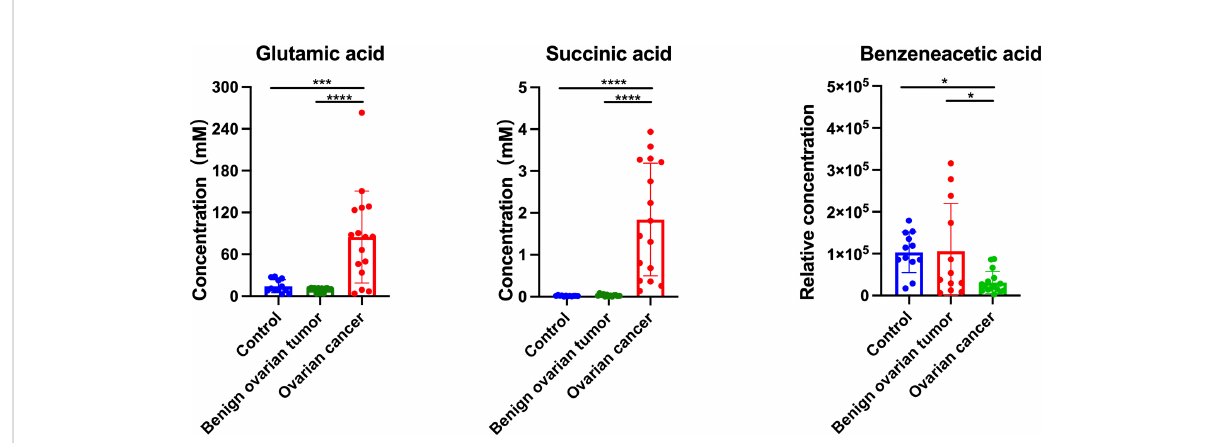
FIGURE 5 The concentration of glutamic acid, succinic acid, and benzeneacetic acid in the urine sample from control, benign ovarian tumor, and ovarian cancer patients of the validation cohort. Black asterisks (*) indicated metabolites with signi fi cantly different levels between ovarian cancer group vs. control group, and ovarian cancer group vs. benign ovarian tumor group using Tukey ’ s Honest Signi fi cant Difference (HSD) test (*p-values < 0.05, ***p-values < 0.001, ****p-values < 0.0001). Number of urine sample in control group (n = 12), BOT group (n = 13), and OC group (n = 16).